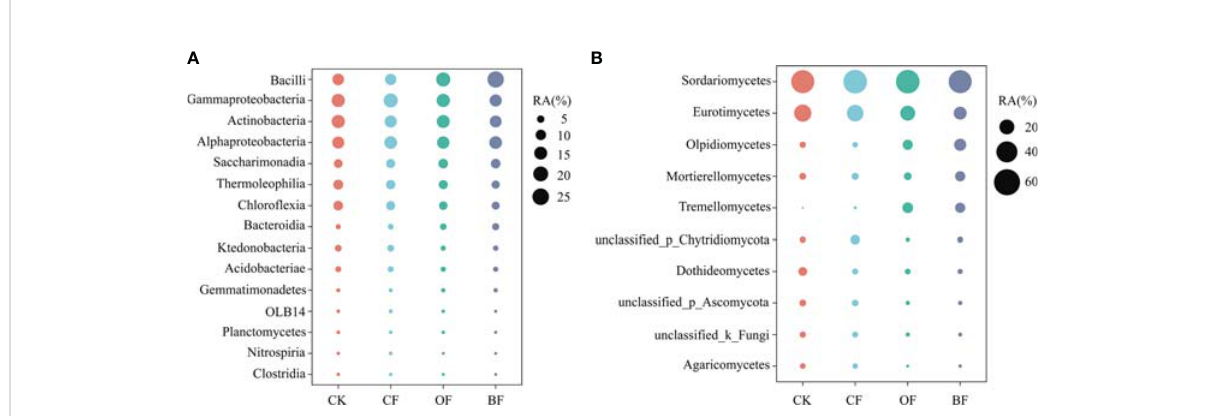
FIGURE 3 Bubble chart of bacterial (A) and fungal (B) classes for different fertilizer treatments. CK is untreated control; CF is chemical fertilizer; OF is organic fertilizer; BF is bioorganic fertilizer. The circular areas represent the average relative abundance (RA) across the six replicate libraries for soil samples collected from each treatment.